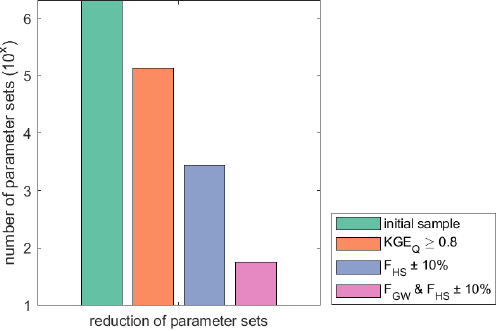
Figure 8. Iterative reduction in the initial sample of 200000 param- eter sets using the KGE Q and hydrograph separation derived from streamflow contributions for the individual years 2013 and 2014, in addition to both years